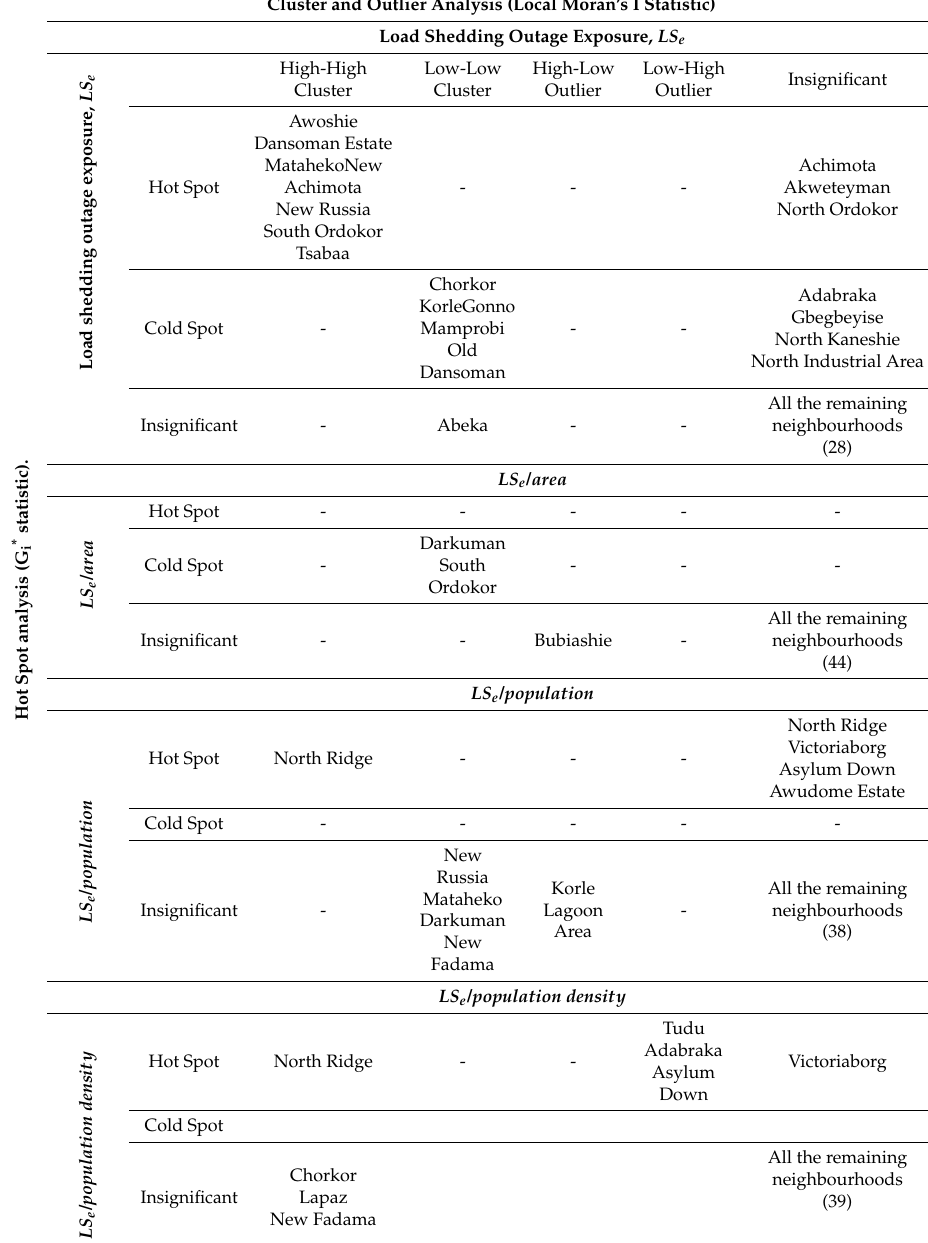
Table 8. Neighborhoods at the intersection of di ff erent spot and cluster / outlier